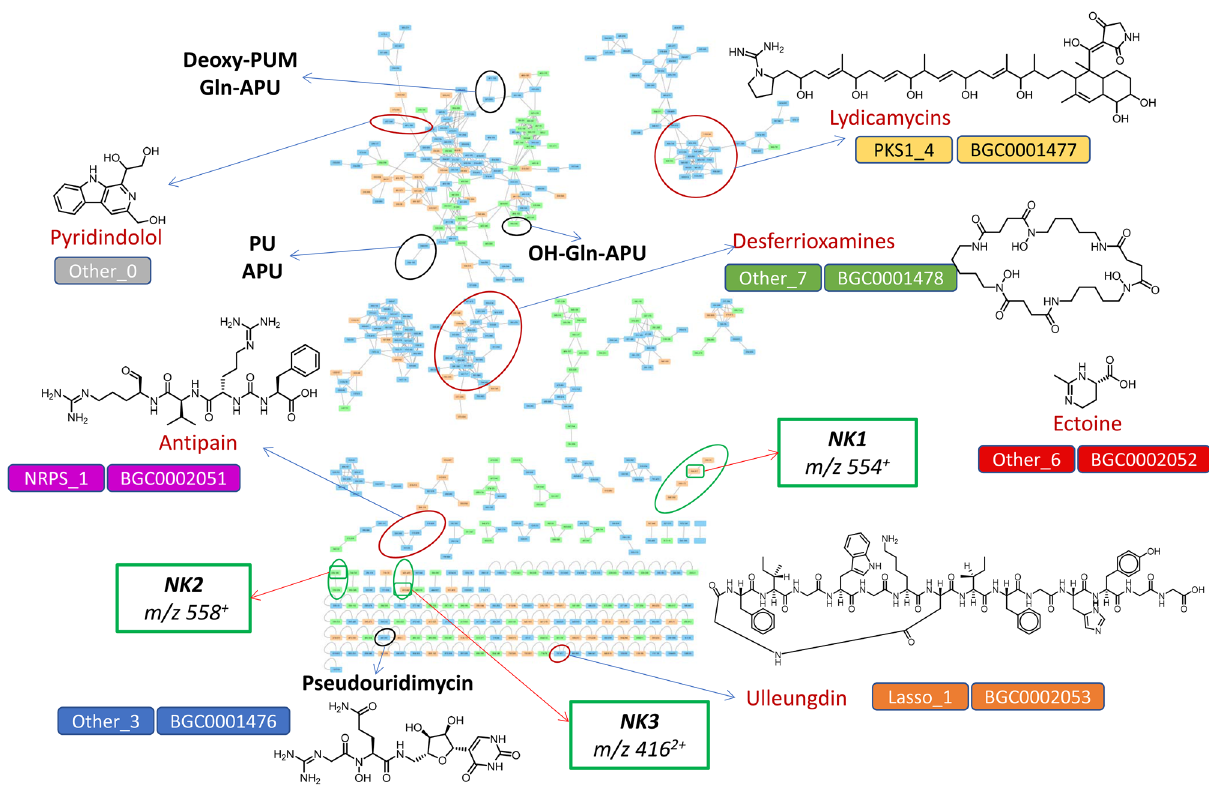
Figure 1. Molecular network of samples from Streptomyces sp. ID38640 and ten knockout pum mutants. The analysis includes two cultures from each strain and two samples per culture. Node colors give the contributing medium: orange for M8, green for PumP1, light blue for nodes observed in both media. Black circles indicate PUM-related nodes, red circles indicate nodes corresponding to known compounds, green circles show unknown metabolites (NK). The associated BGCs, as listed in Table 2, are shown next to each